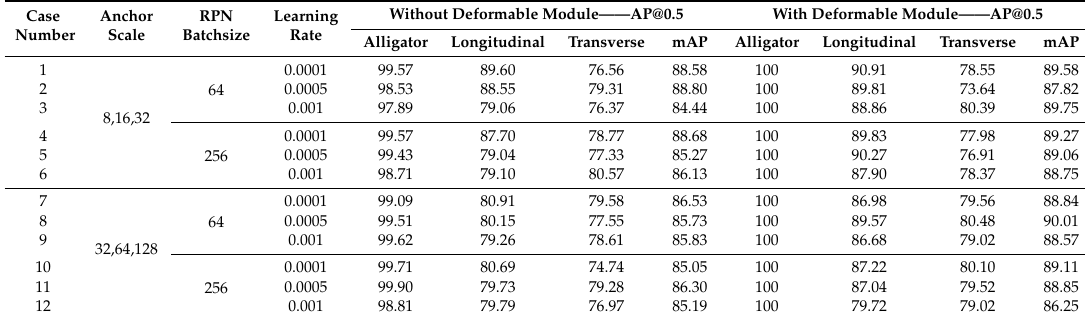
Table 2. Testing Results of R-FCN.